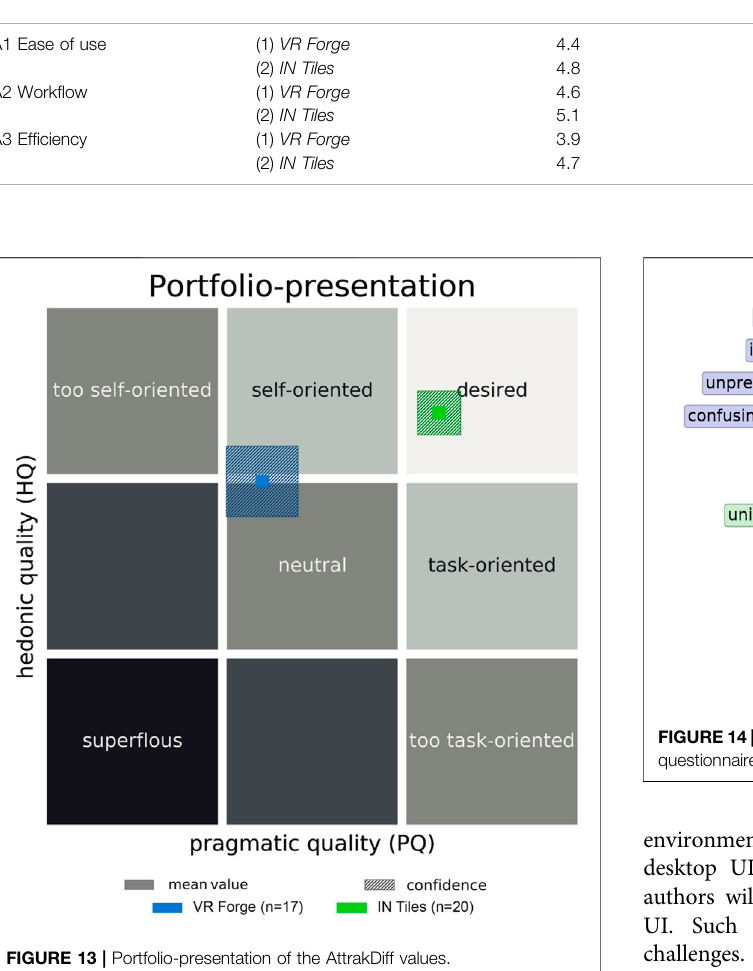
TABLE 2 | Analysis of signi fi cant differences between the A1 – A3. Mann-Whitney U tests were utilized. All values are rounded. Aspect